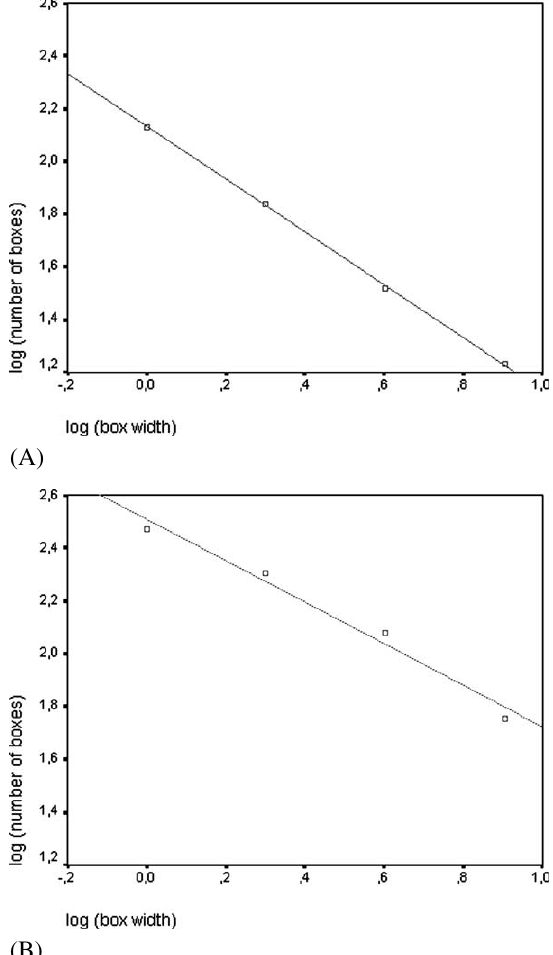
Fig. 3. (A): Log–log graph of box number versus box width for a sample of CK stained slides. The slope of the regression line in- dicates the box-counting fractal dimension (FD = 1 . 000000938). (B): Log–log graph for a sample of LCA stained slides (FD = 0 .